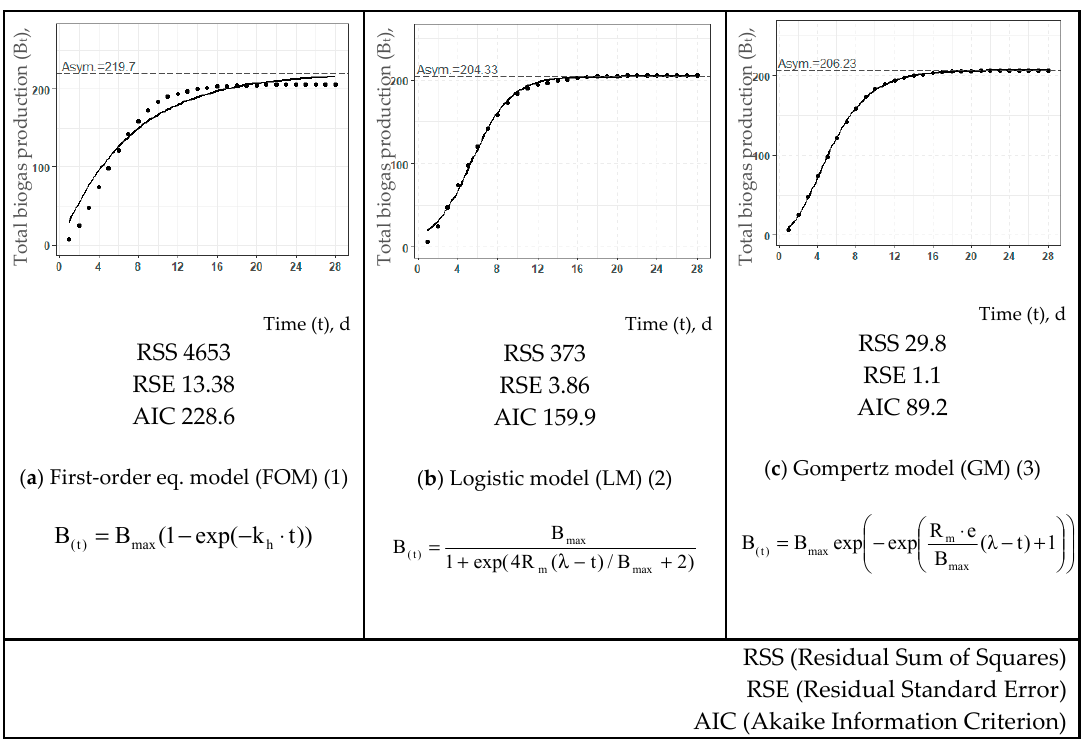
Figure 2. Curves of models matching experimental data of total biogas production (L/kg DOM) from raw bio-waste.